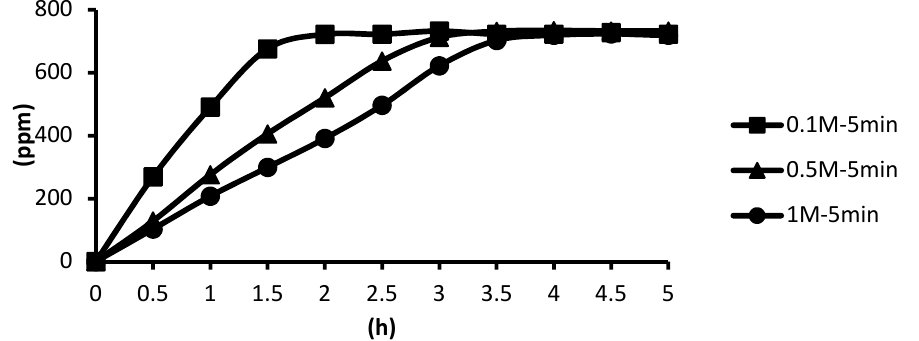
Figure 19. The effect of CaCl 2 concentration (cross-linking time of five minutes) on releasing of tea tree essential oil from alginate/tea tree essential oil microcapsules in the hot spring water.